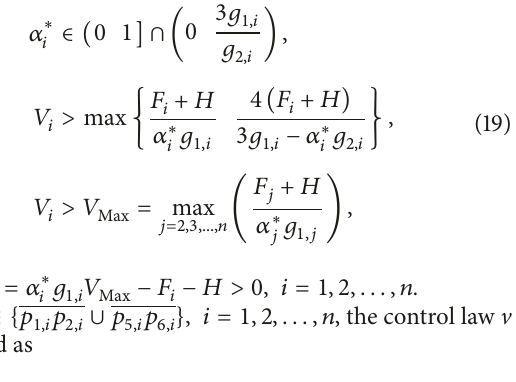
Figure 2: An example of the state-space